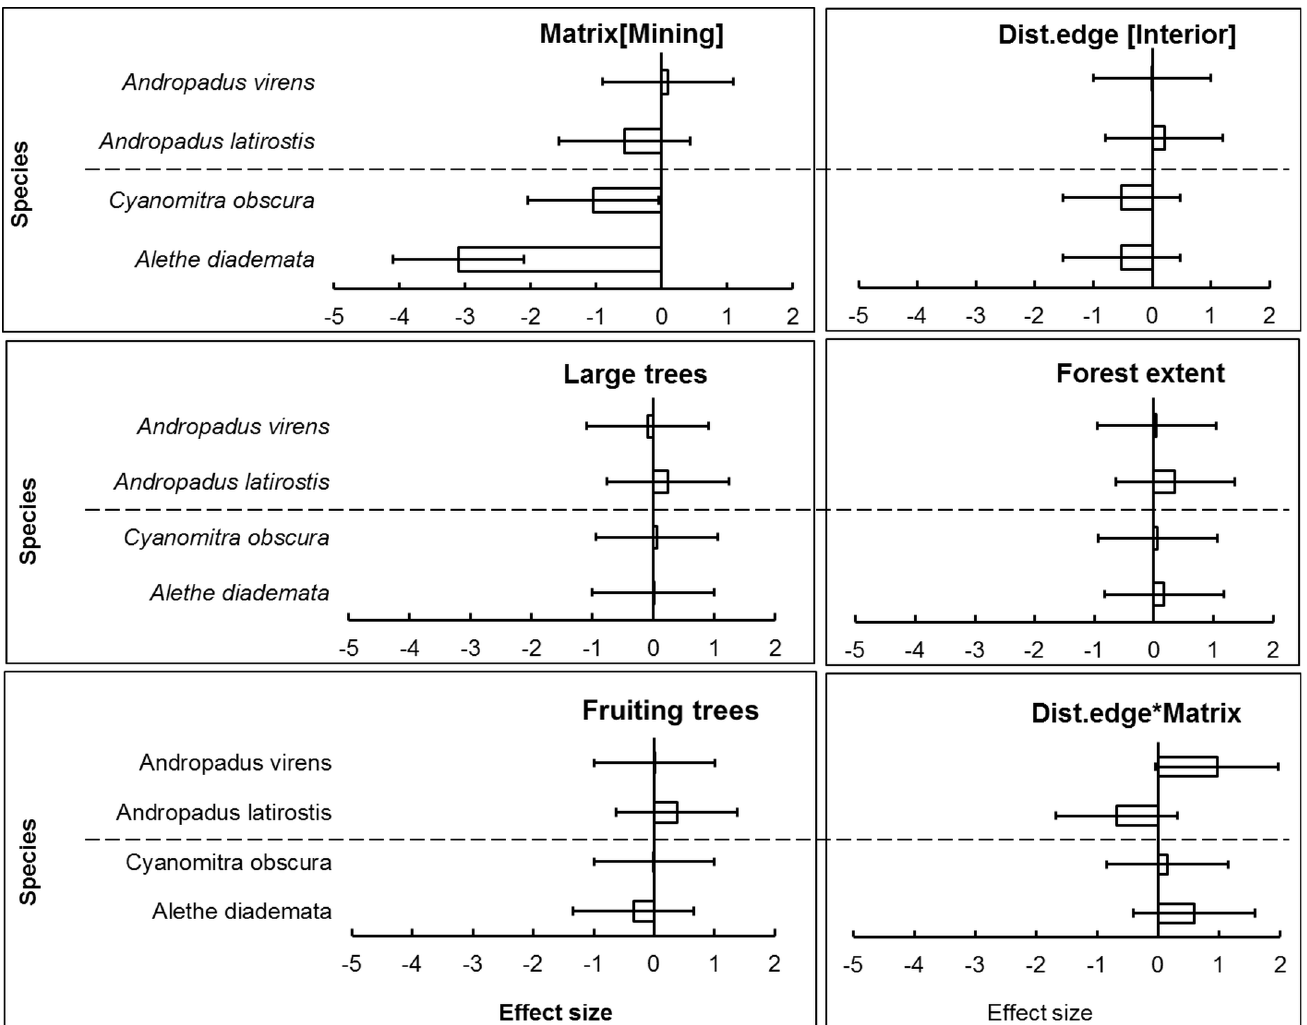
Fig 4. Model-averaged coefficients (error bar = 95% CI) of explanatory variables ’ influence on residual body mass of all case study species. Generalist above the horizontal dashed line and specialists below in each